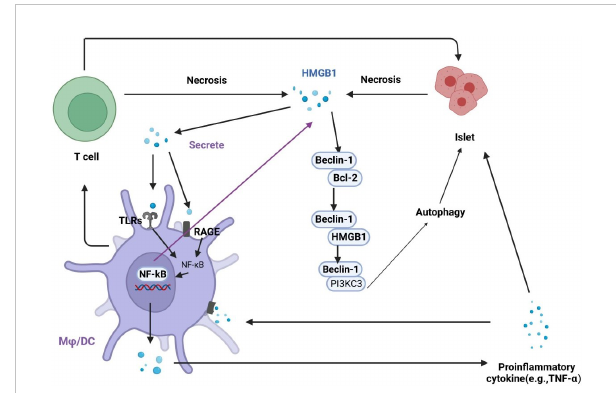
FIGURE 4 Regulation of the interplay between autophagy and HMGB1 in islet injury. HMGB1 promotes early in fl ammation in diabetes and leads to necrosis in islet cells. Necrotic cells release HMGB1, which activates TLRs and RAGE on macrophages and dendritic cells. The activation of TLRs and RAGE leads to the translocation of NF- k B into the nucleus to promotes the expression of in fl ammatory genes, which contributes to the secretion of proin fl ammatory cytokines, including HMGB1. In addition, activated macrophages and dendritic cells actively secrete HMGB1, exacerbating islet cell necrosis. HMGB1 can competitively interact with Beclin-1 to disrupt the Beclin-1/Bcl-2 interaction, which promotes